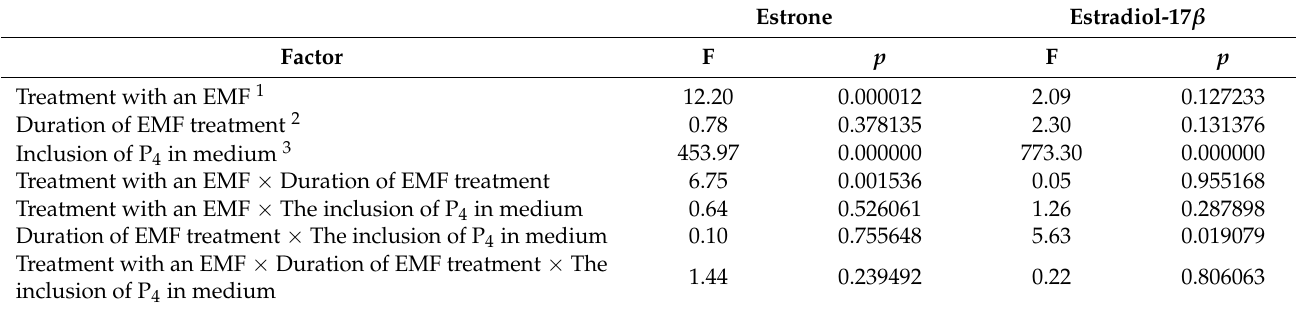
Table 3. The main factors and the interactions affecting the concentration of estrone and estradiol-17 β in the culture medium, released by porcine myometrium collected from pigs during the peri-implantation period (days 15–16 of pregnancy) and treated in vitro with an EMF at 50 and 120 Hz for 2 and 4 h of incubation with or without the inclusion of P 4 (multi-way